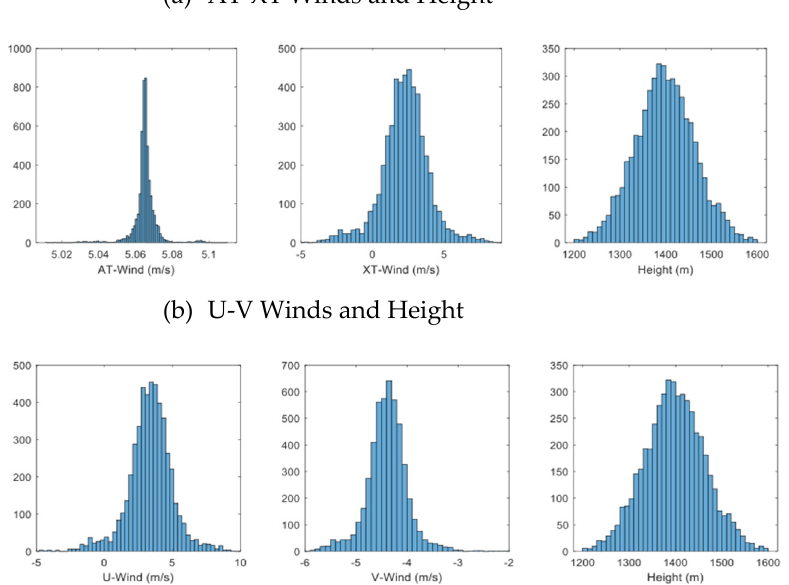
Figure 15. CMIS winds over Hold D1 where the mean wind height is constrained to approximate the CALIOP layer-1 top are shown with ( a ) winds resolved AT-XT and ( b ) U-V. The Hold-D1 collection has an Aqua overpass approximately an hour earlier at 17:55Z that was used for MODIS and GOES-16 stereo winds to corroborate the CMIS results. A larger domain (41.25 ± 1°, − 79.05 ± 1°) is considered since the density of satellite retrievals is much less than those from CMIS and there is approximately a one-hour time mismatch. The distribution of MODIS-GOES stereo winds within this domain is shown in Figure 16. The mean CMIS retrieval of (3.38, − 4.39) m/s falls near the most probable satellite U-V winds and its 5.54 m/s speed and mean height of 1400 m also falls near the most probable speed-height combinations.